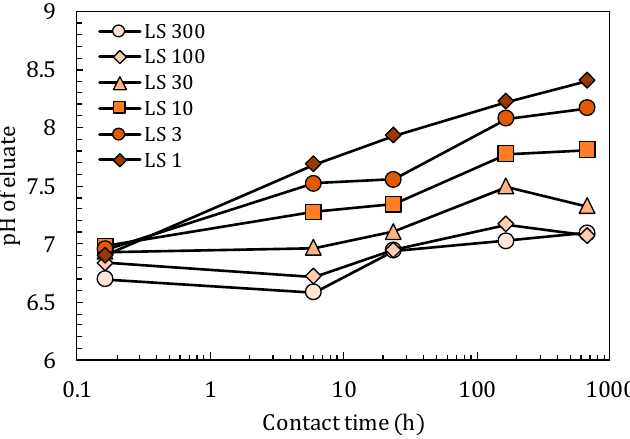
Figure 2. Change in pH in the LS-parallel test as a function of contact time.